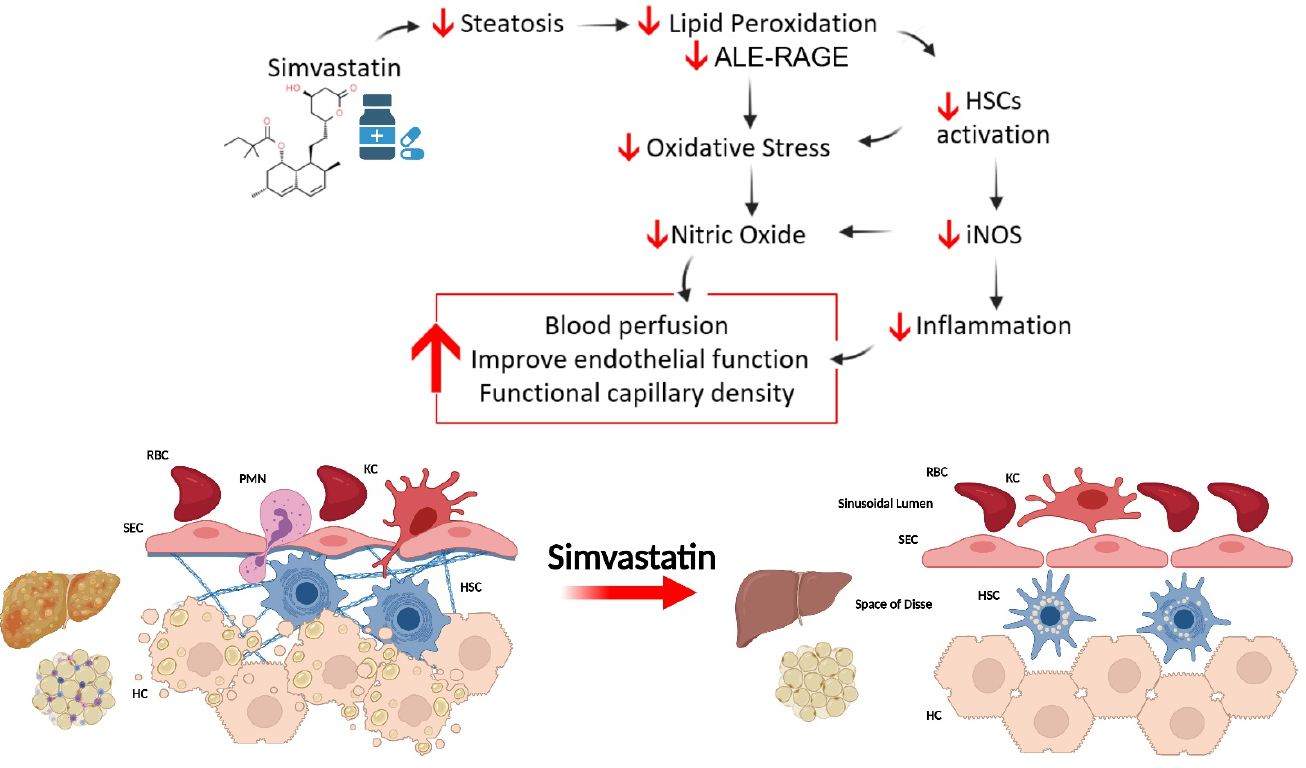
Figure 6. The impact of oral treatment with SV on the development of NAFLD. SV acts on multiple key insults that together contribute to the onset and progression of NAFLD. In this context, SV pro- tects against NAFLD-induced (i) metabolic changes, (ii) microcirculatory dysfunction, and (iii) oxi- dative damage and inflammation. HSC: Hepatic stellate cells; RBC: Red blood cell; PMN: Polymor- phonuclear leukocytes; KC: Kupffer cells; SEC: Liver sinusoidal endothelial cells; HC: Hepatocytes.